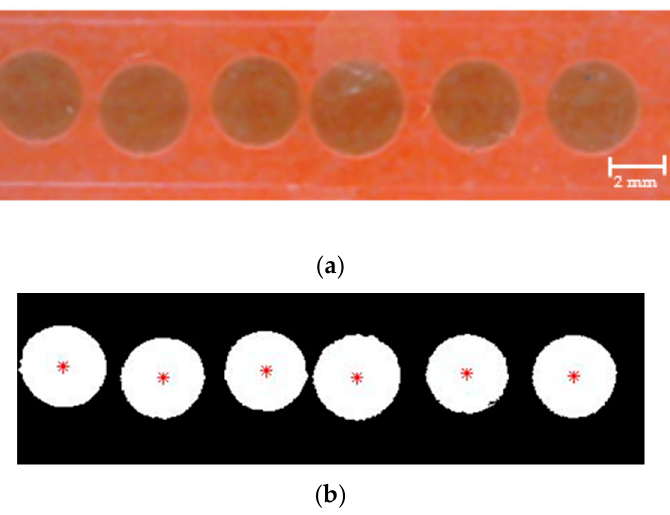
Figure 13. Droplet identification: ( a ) Original RGB image; ( b ) Detected droplets using DIP.